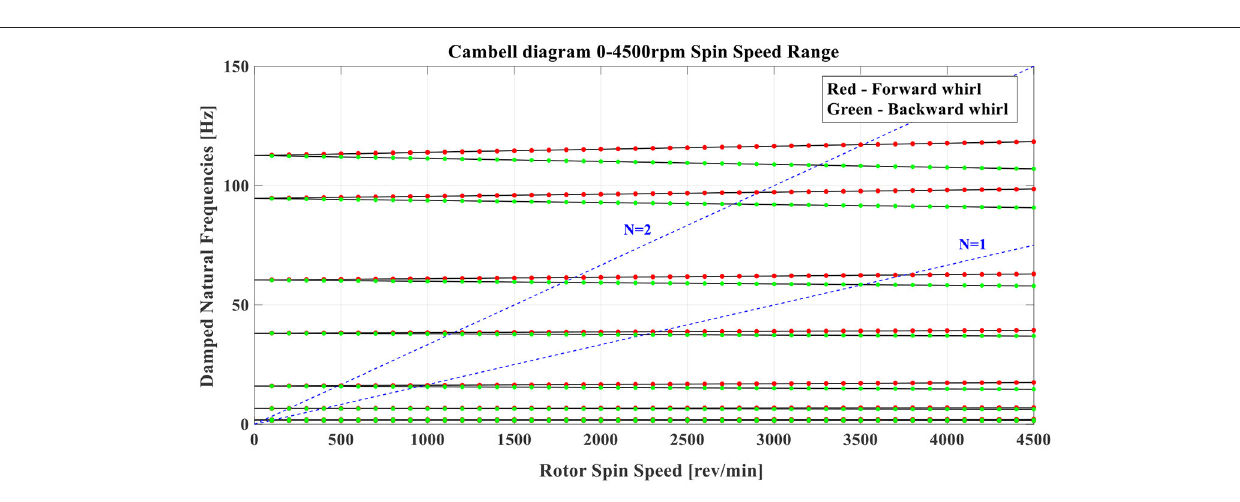
FIGURE 15 | Cambell diagram at 0–4.500 rpm spin speed